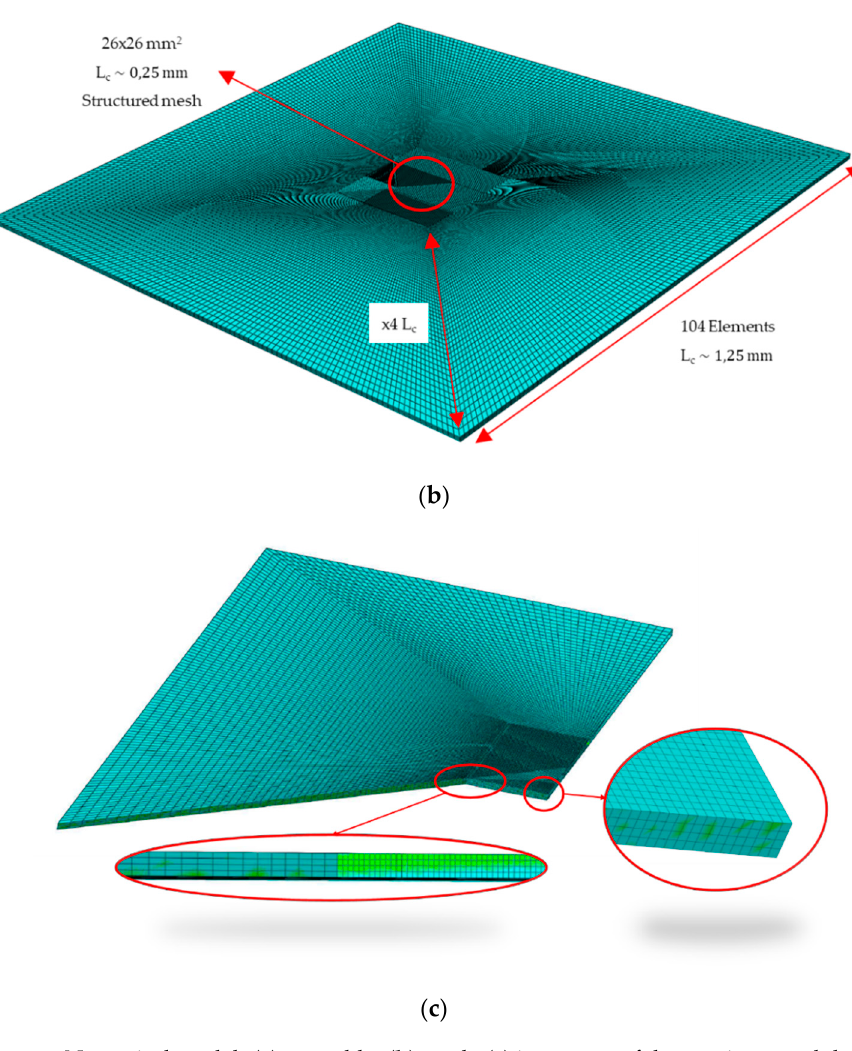
Figure 10. Numerical model: ( a ) assembly; ( b ) mesh; ( c ) inner part of the specimen and details.